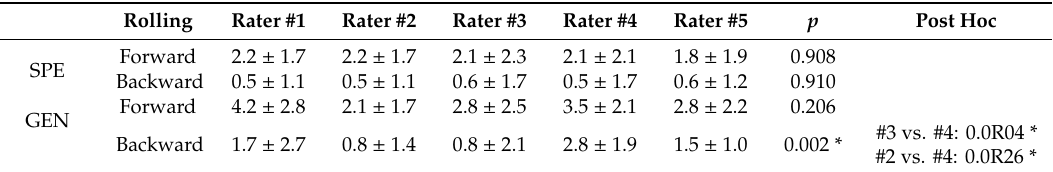
Table 2. Inter-rater reliability of the